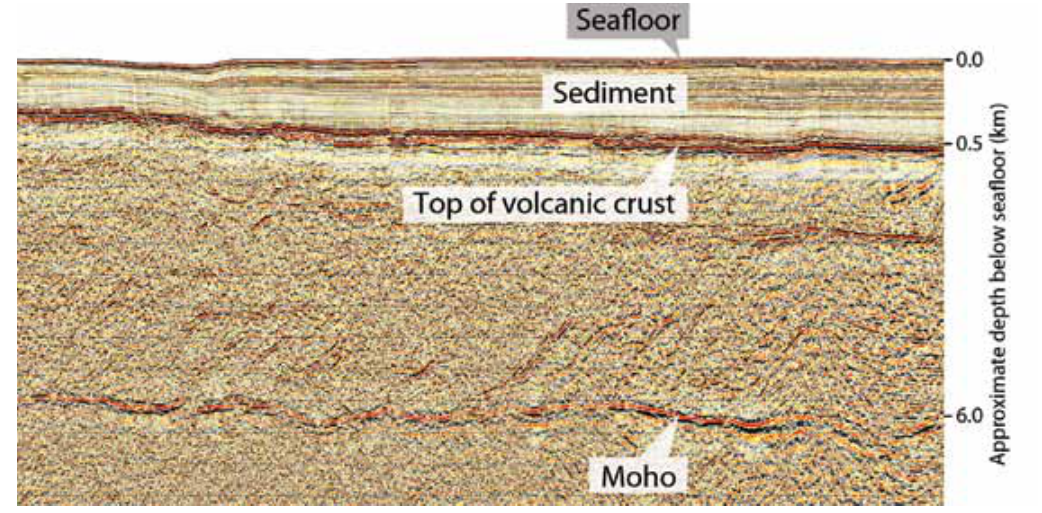
figure 4.4. photomicrograph of an intrusive rock from the deep oceanic crust observed in cross-polarized light. The brightly colored olivine crystals preserve a record of deep crustal and mantle processes that can be deciphered with state-of-the-art trace element, isotope, and gas analyses. photo is ~20 mm across. courtesy of Benoit ildefonse, Université monpellier.